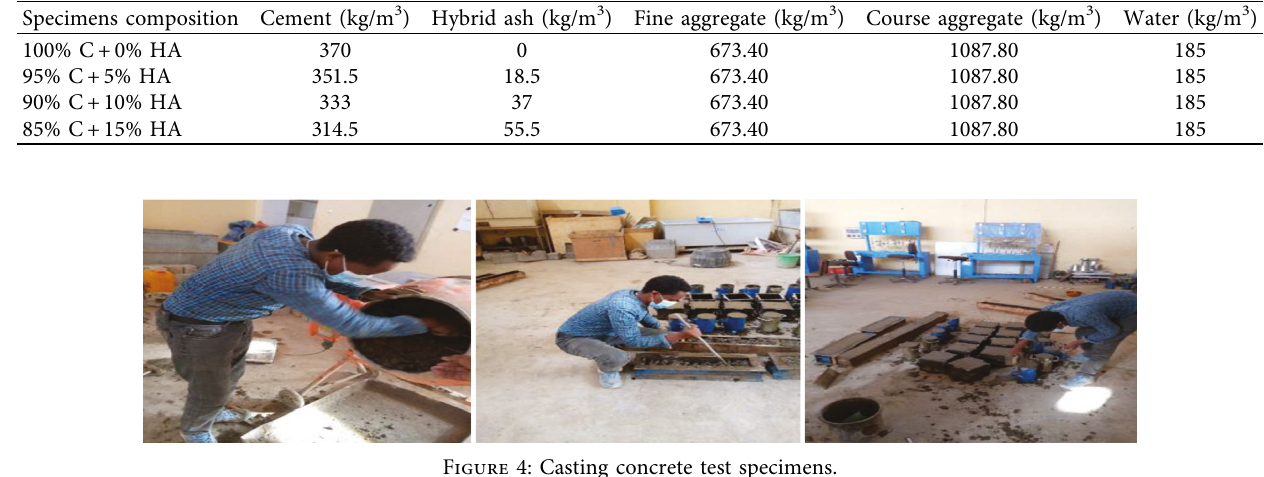
Table 5: Content of concrete constituent for test.